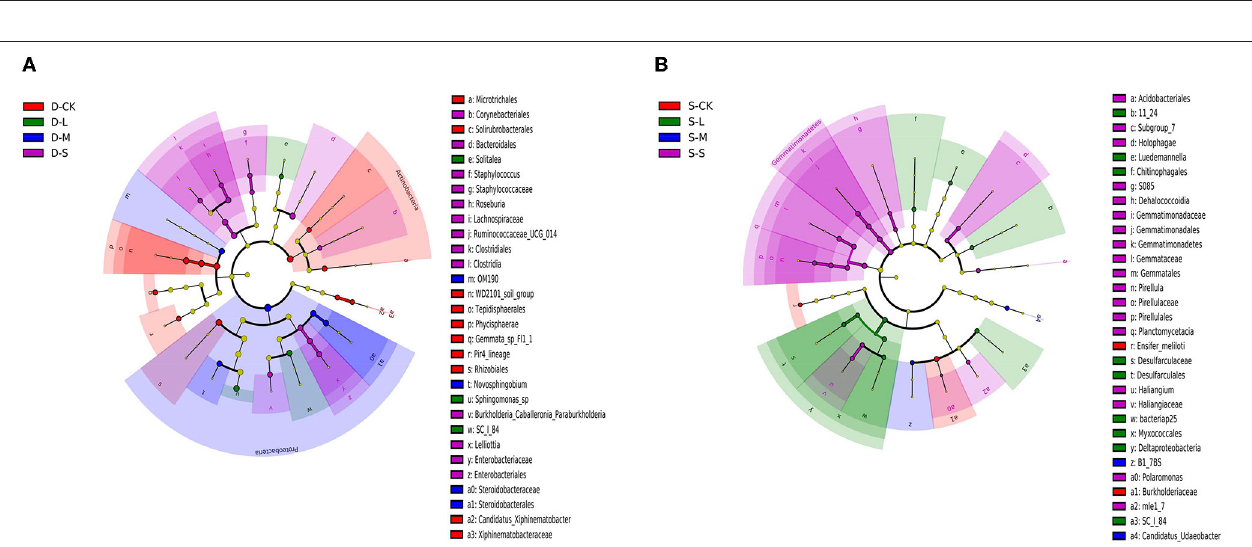
FIGURE 3 | Relative abundance of bacteria taxa at the phyla level. Only the taxa with the average relative abundance of the top 10 are shown. * p < 0.05; ** p < 0.01. D-S, small gaps in winter; D-M, medium gaps in winter; D-L, large gaps in winter; D-CK, no forest gaps in winter; S-S, small gaps in summer; S-M, medium gaps in summer; S-L, large gaps in summer; and S-CK, no forest gaps in summer.